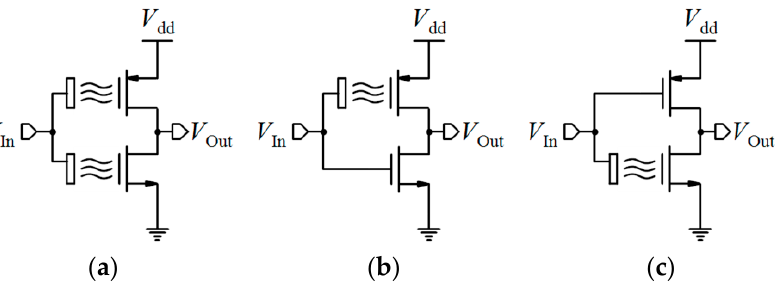
Figure 28. Three configurations of ISFET inverters: ( a ) p-type and n-type ISFET sharing the same membrane; ( b ) p-type ISFET with membrane and n-type MOSFET; ( c ) n-type ISFET with membrane and p-type MOSFET.